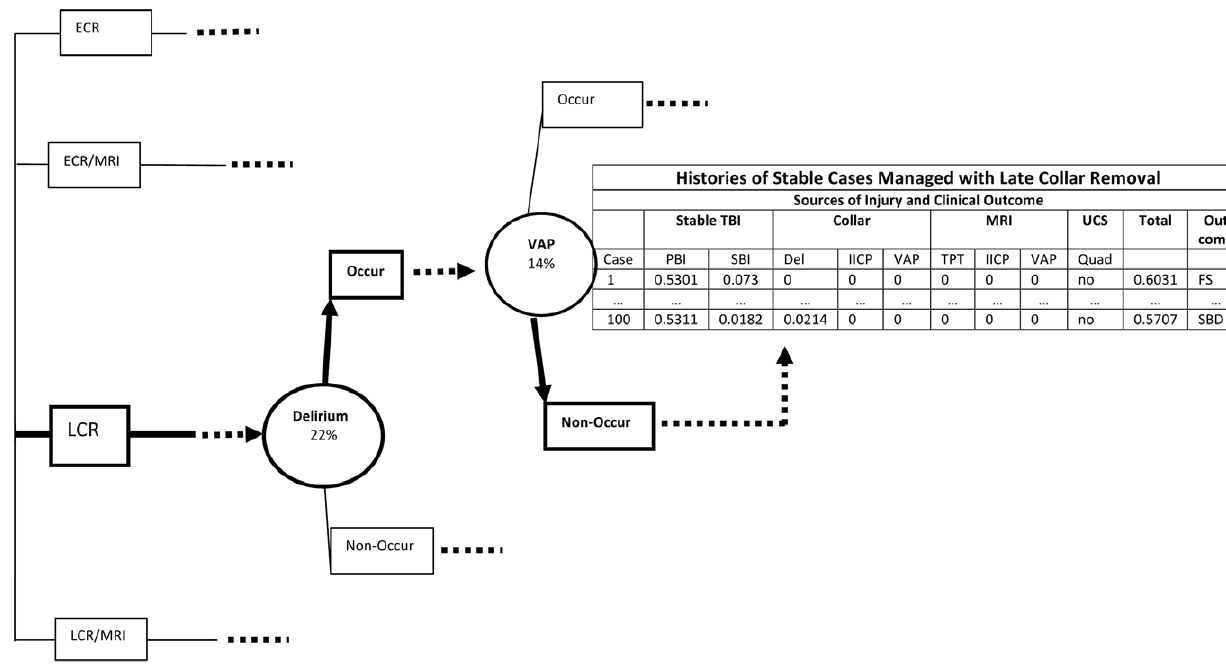
Figure 1. History of Events Leading to Severe Brain Disability Managed with Late Collar Removal for Case # 100.